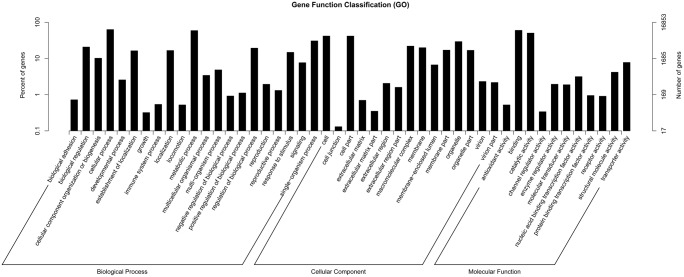
GO classification of unigenes of P. avium L fruit.The results are summarized in three main GO categories: Biological process, Cellular Component and Molecular Function.